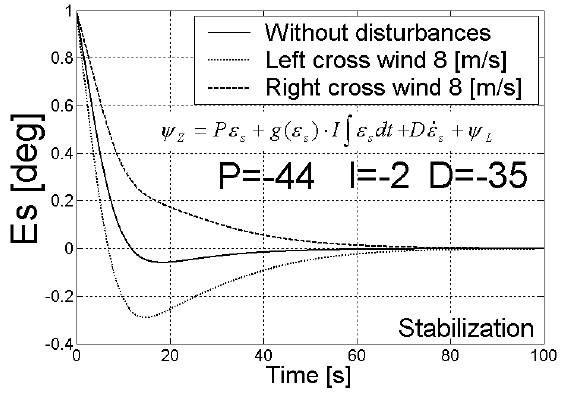
Fig 3d. Simulation results for stabilization with the use of